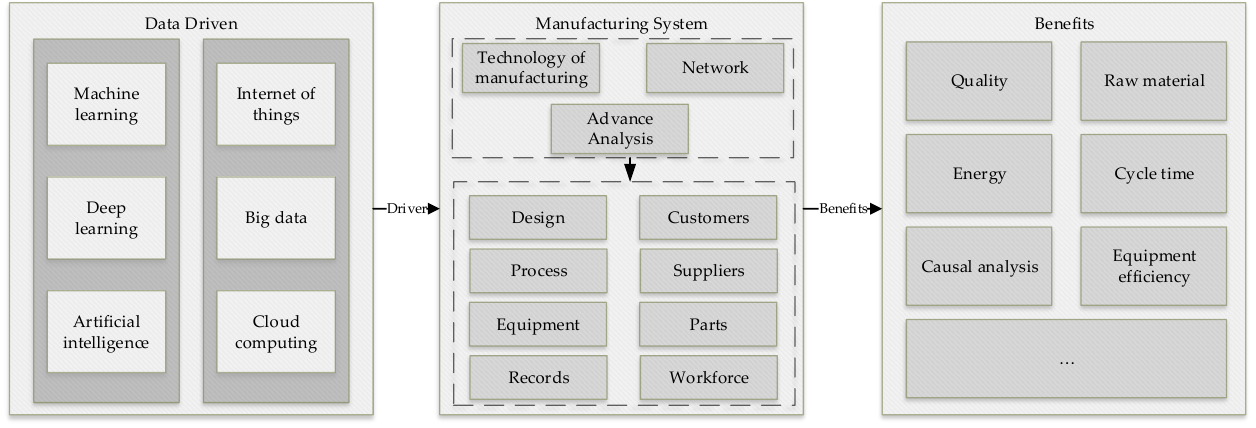
Figure 1. Smart manufacturing’s data-driven